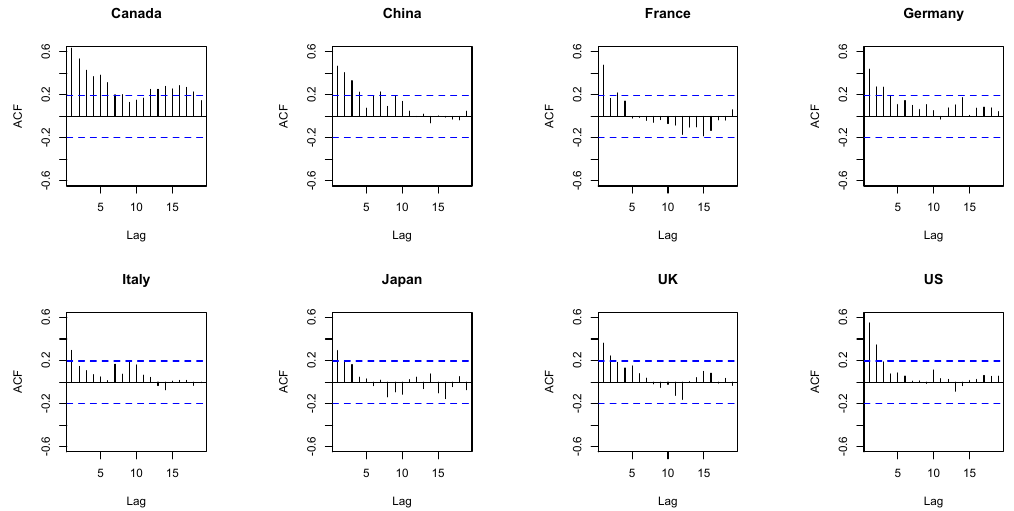
Figure 5. Autocorrelation functions of uncertainties. Dashed horizontal lines: bounds of the 95% confidence